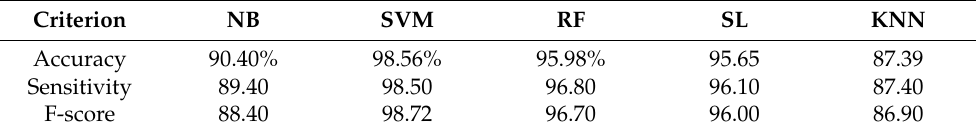
Figure 6. Heart rate measurement analysis using MATLAB. ( a ) The first time when the subjects were examined. ( b ) The second time of heart rate measurements. ( c ) The third time of heart rate measurements. Table 12. Performance of five machine learning